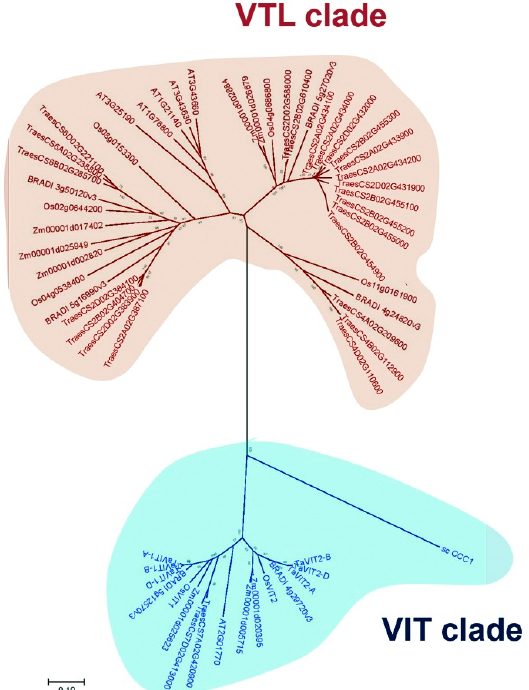
Figure 1. Phylogenetic analysis showing separation of vacuolar iron transporter (VIT) family in Arabidopsis , Brachypodium , Oryza sativa , Zea mays and Triticum aestivum into two distinct clades; vacuolar iron transporter-like (VTL) clade and VIT clade. The neighbour-joining phylogenetic tree was generated using MEGA. The numbers represent bootstrap values from 1000 replicates.